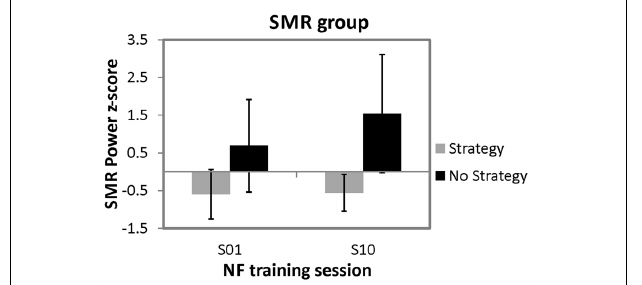
FIGURE 3 | Means and standard deviations of z -transformed SMR (12–15Hz) power (NF performance) over the ten NF training sessions, presented separately for participants reporting to use a specific mental strategy in the tenth NF session (strategy group) and participants reporting no specific mental strategy in the tenth NF session (no strategy group) of the SMR group and the results of the regression